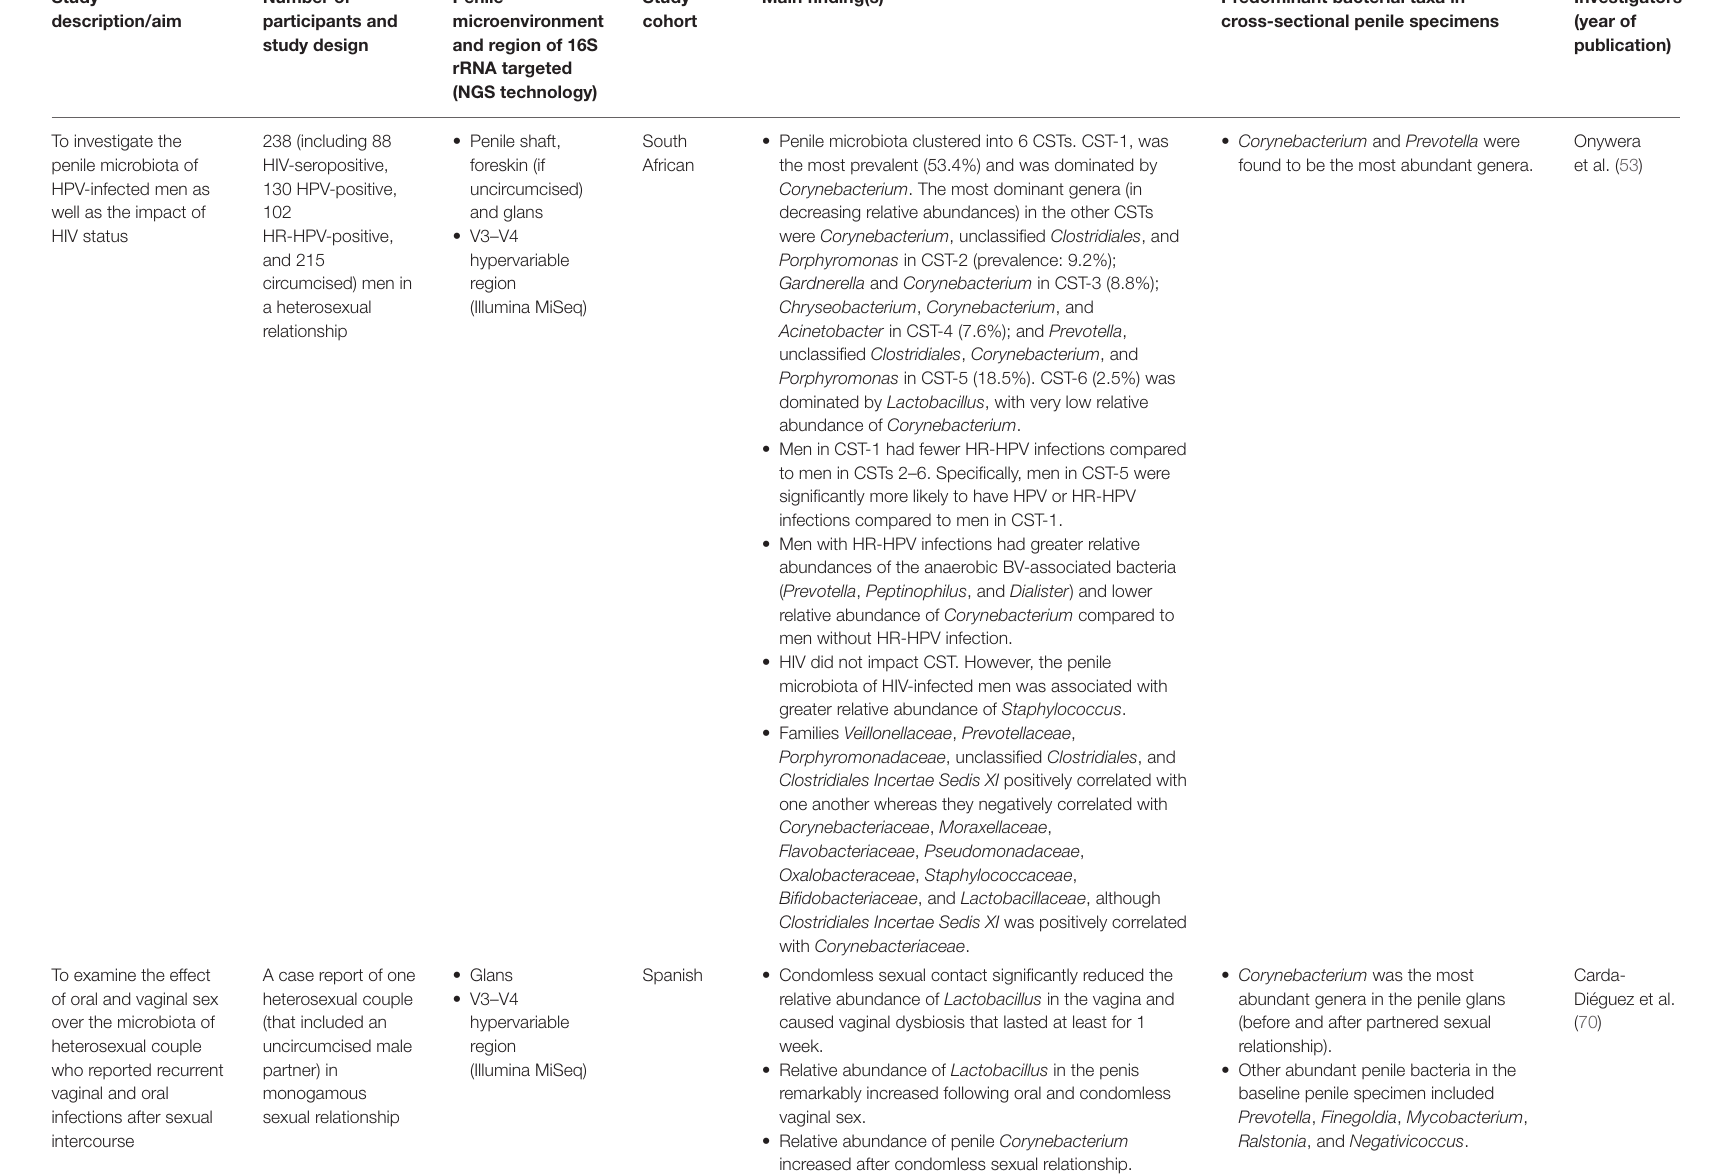
TABLE 1 | Summary of findings from penile microbiota studies carried out to